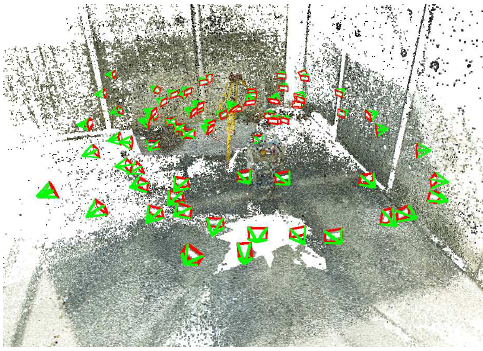
Figure 6: The circular geometry of the acquisition After performing the bundle block adjustment, the targets ~p i | k lo- cated on the camera 3 to be calibrated are measured in the images k and their 3 d coordinates ~P i estimated by pseudo-intersections.